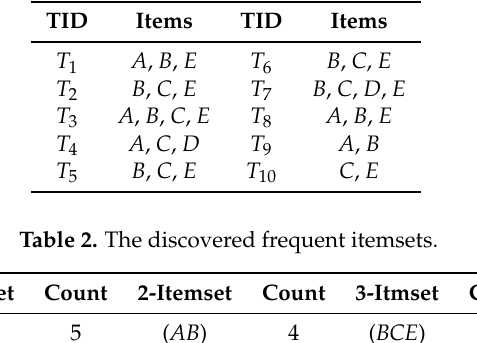
Table 1. The original database.